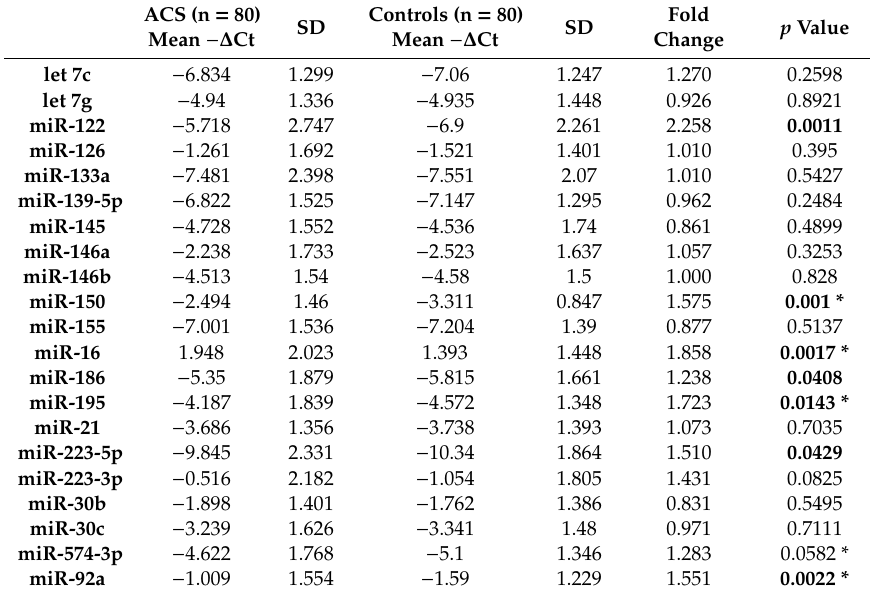
Table 2. Twenty-one miRNAs selected and analyzed in the validation